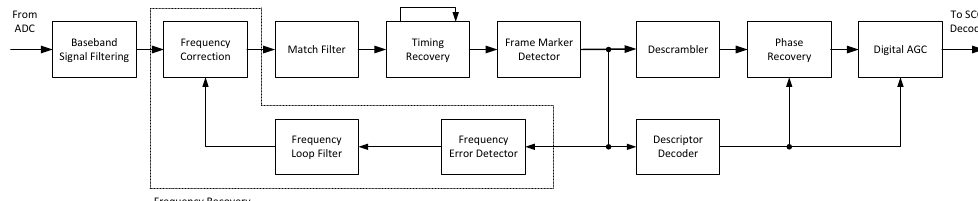
Figure 19. Proposed CCSDS 131.2-B-1 receiver